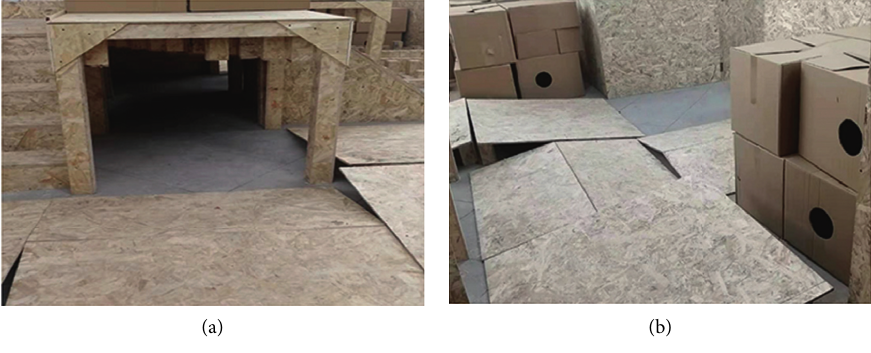
Figure 16: China robot competition venue.